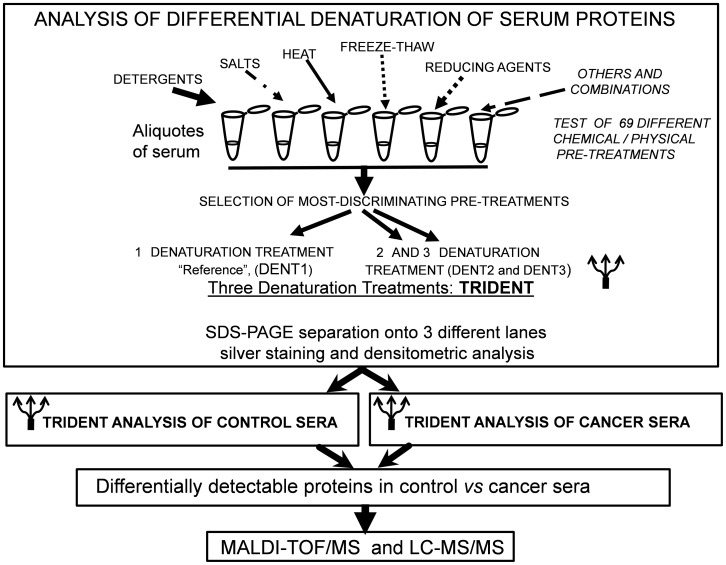
The differential serum denaturation protocol.Schematic representation of chemical-physical pre-treatments of sera and following analytical procedures.